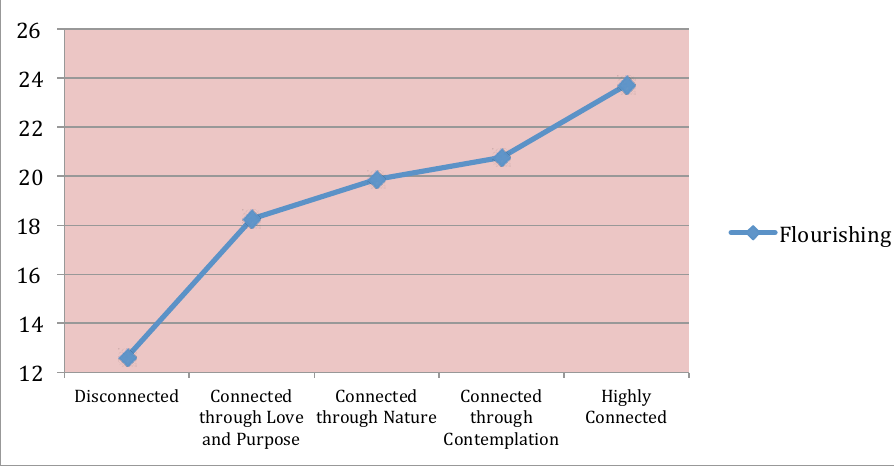
Figure 9. One-way ANOVA of mean flourishing across five classes of spiritual connection, F =57.50*.* p <